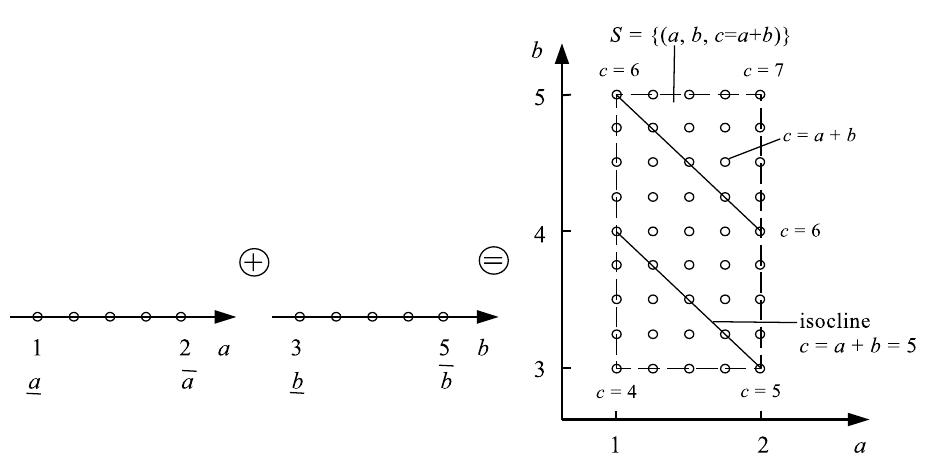
Figure 3. Illustration of the operation of adding 2 interval sets [ a ] and [ b ] and the 3D result of this operation S { ( a , b , c ) } presented as a projection on 2D-space A × B